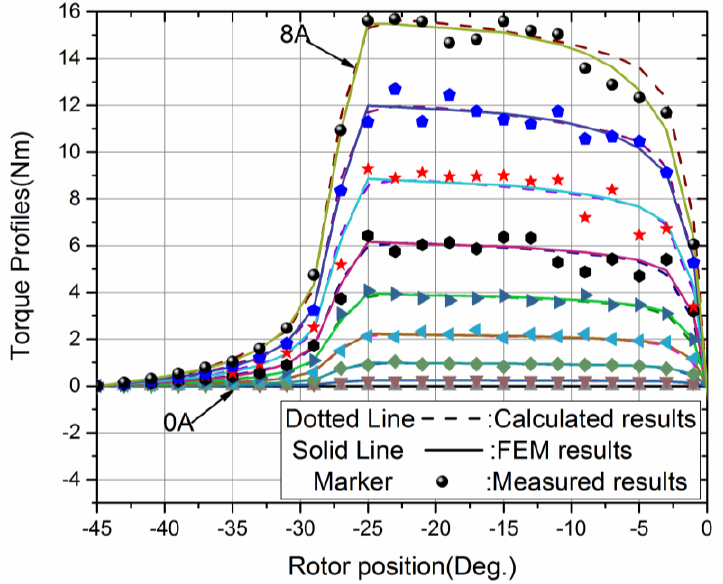
Figure 9. Comparison of the calculated, FEM, and measured static torque characteristics for 0 to 8 A with an increment of 1 A.